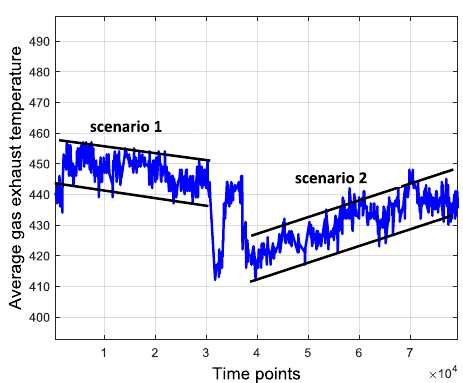
Figure 5. Uncertainty of gas exhaust temperature.